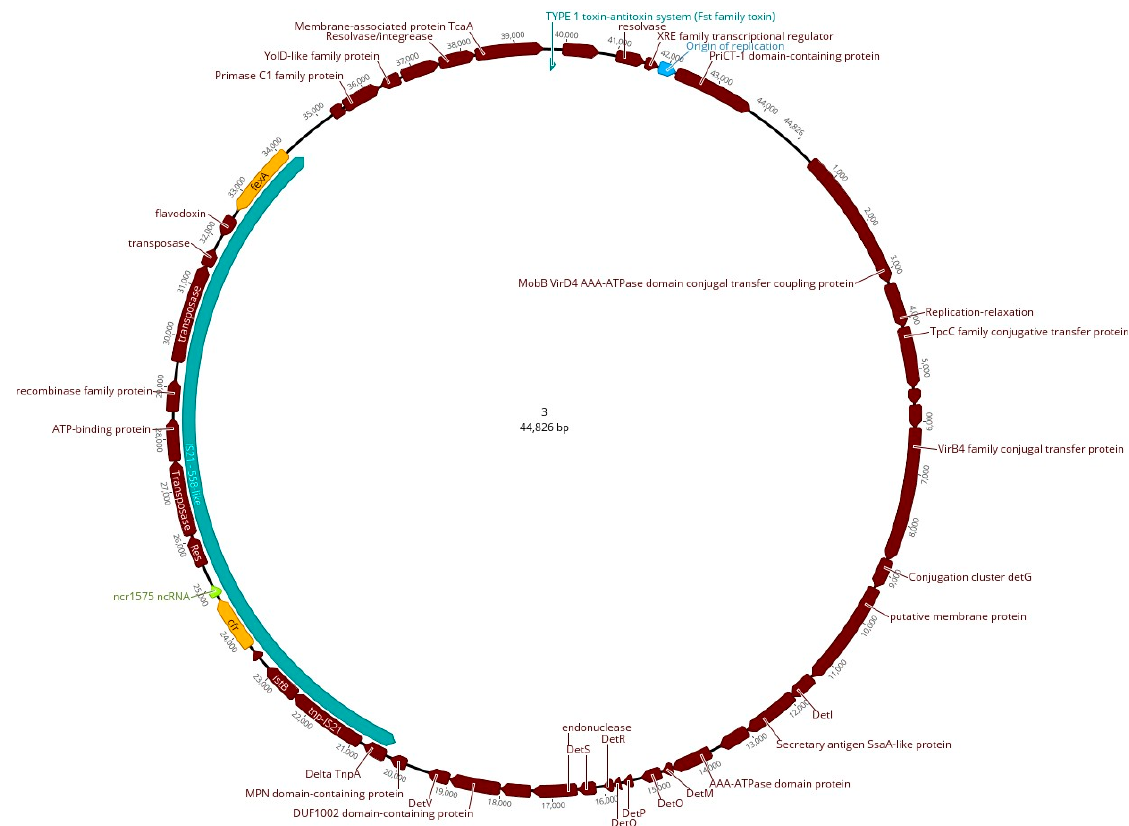
Figure 3. Graphical representation of the cfr -carrying plasmid (pMOL21554) of isolate ID 21554/1.